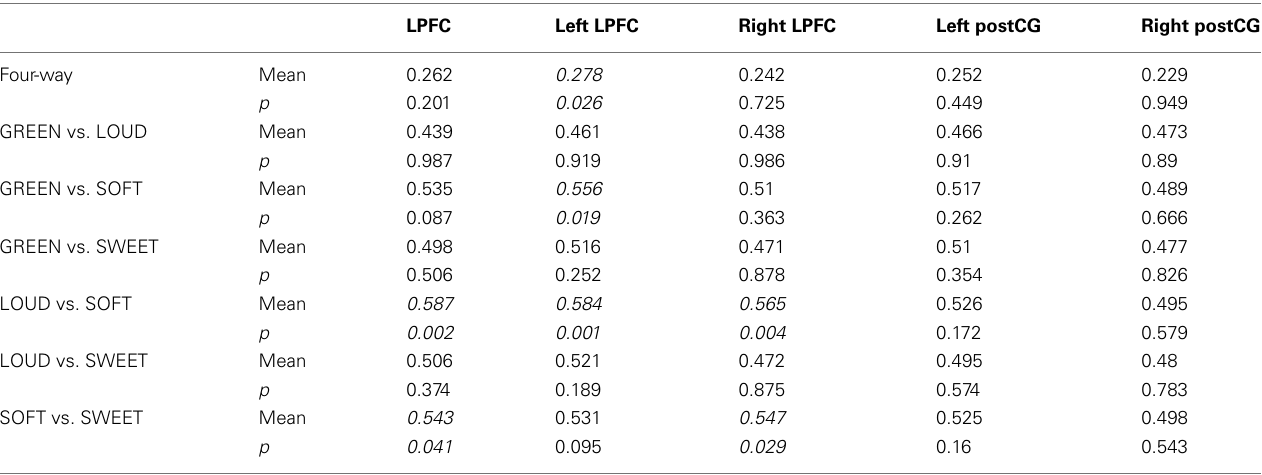
Table 3 | Semantic rule classification test results.